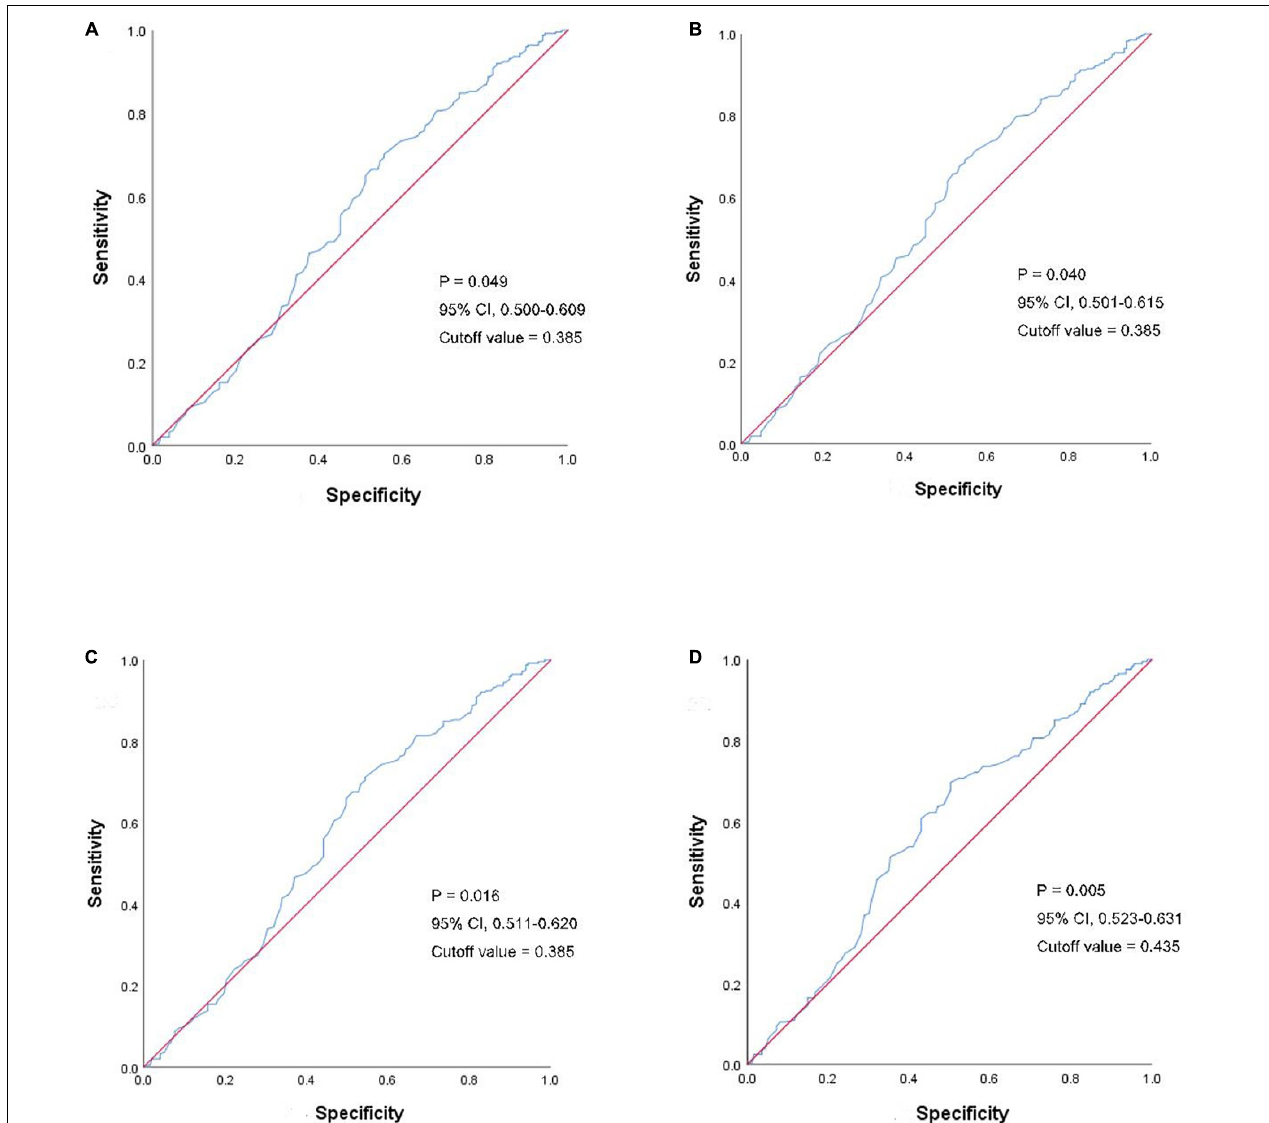
FIGURE 3 | ROC analyses of the LH difference ratio in clinical outcomes. The blue line shows the LH difference ratio and the red line is the control. (A) ROC analyses of LH difference ratio in embryo implantation. (B) ROC analyses of LH difference ratio in a biochemical pregnancy. (C) ROC analyses of LH difference ratio in clinical pregnancy. (D) ROC analyses of LH difference ratio in the live birth. ROC, receiver operating curve; LH, luteinizing hormone.